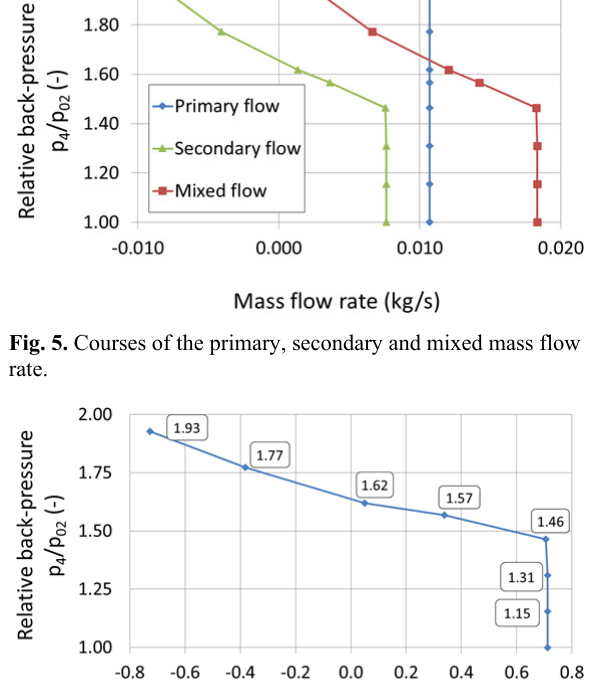
Fig. 10. Contours of Mach number for back-pressure p 4 /p 02 = 1.57, (152 kPa abs).